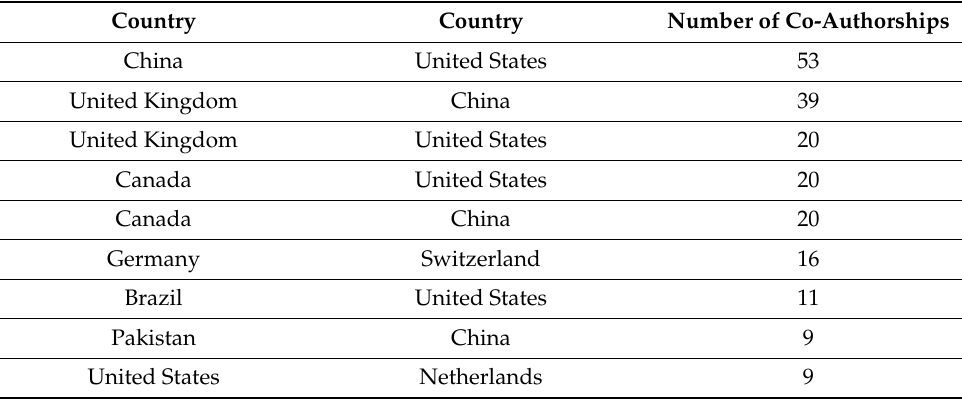
Table 13. Countries with the most co-authorships of CSE publications.